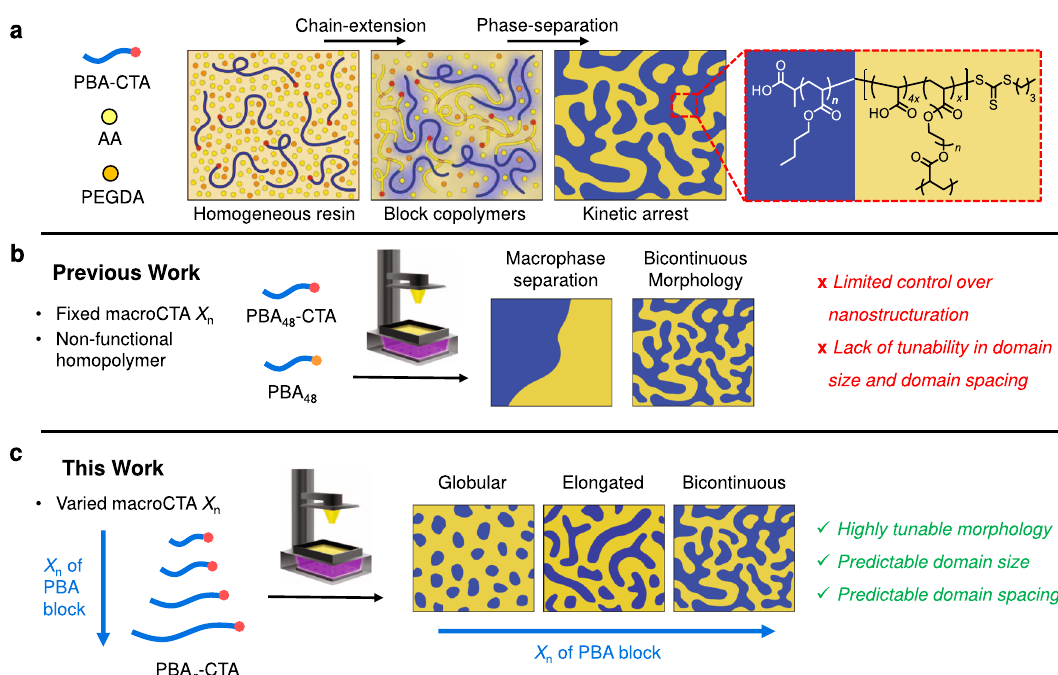
Fig. 1 3D printing materials by RAFT-mediated PIMS. a PIMS mechanism: a macroCTA is chain extended with acrylic acid (AA) and poly(ethylene glycol) diacrylate (PEGDA) to form block copolymers, which eventually phase-separate with the generation of emergent morphologies trapped by in-situ cross- linking. b Previous work using PBA-CTA with fi xed chain length blended with non-functional PBA to 3D print PIMS materials with limited control over morphology. c Current work using PBA-CTAs with varied chain length to investigate structure-property relationships of 3D printed PIMS materials.